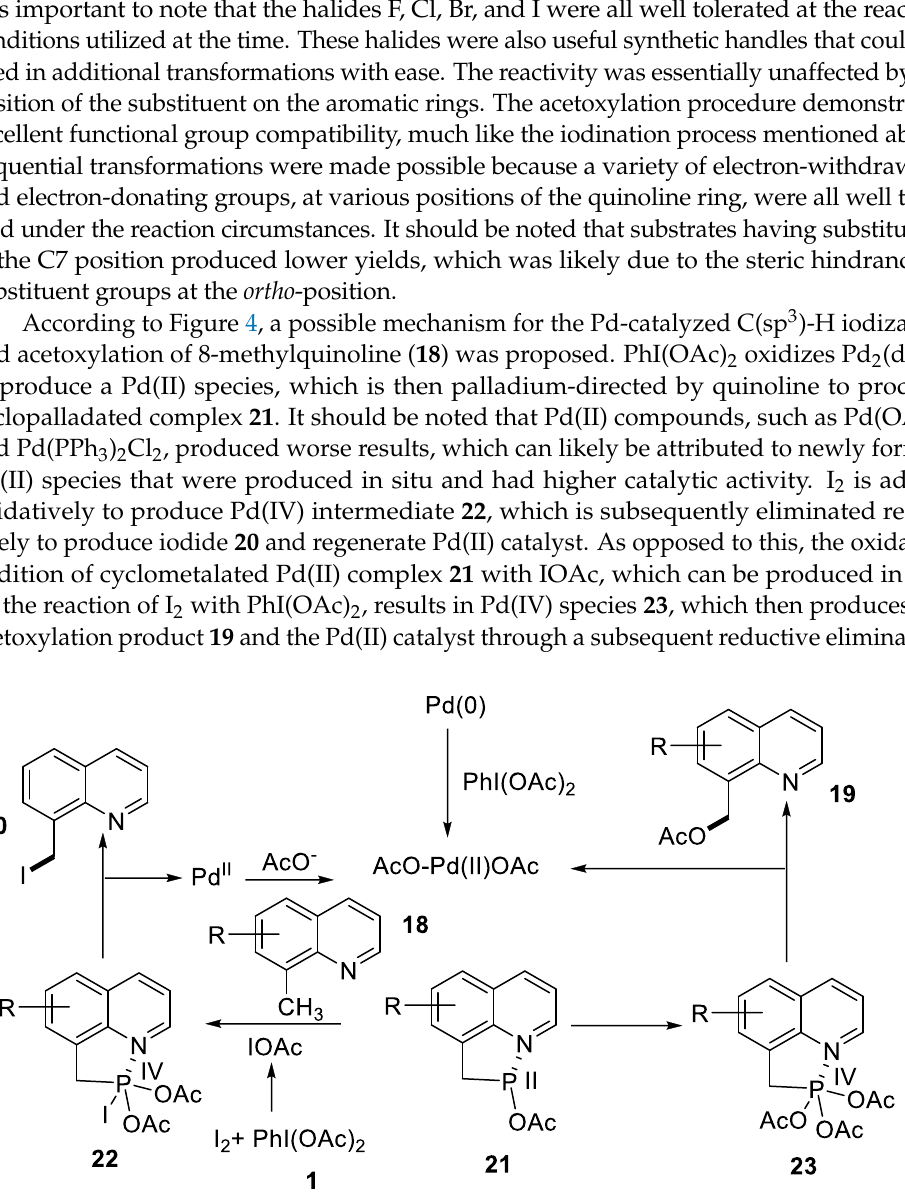
Figure 4. Proposed mechanism for selective iodination/acetoxylation.